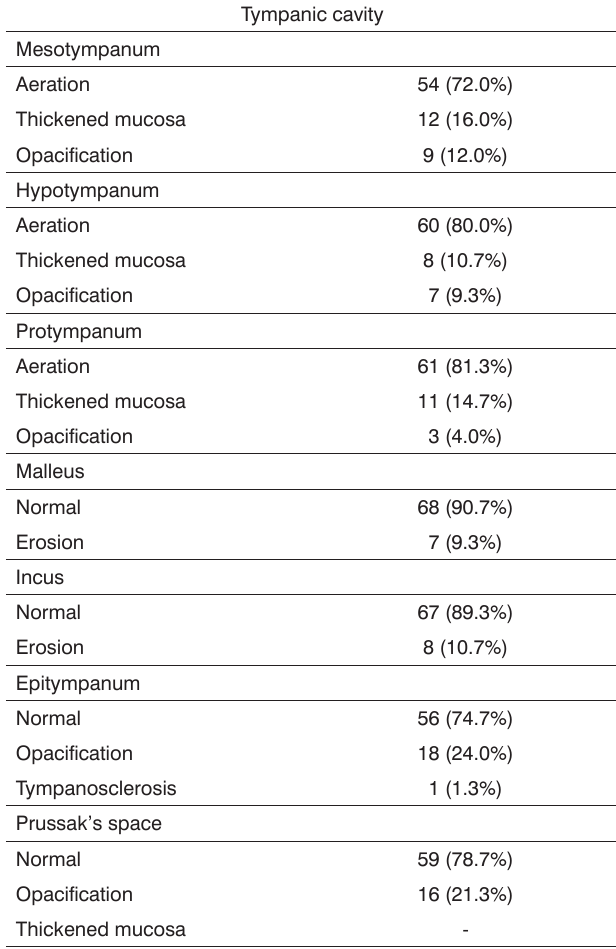
Table 2. Description of the radiological findings in the contra- lateral middle ear.